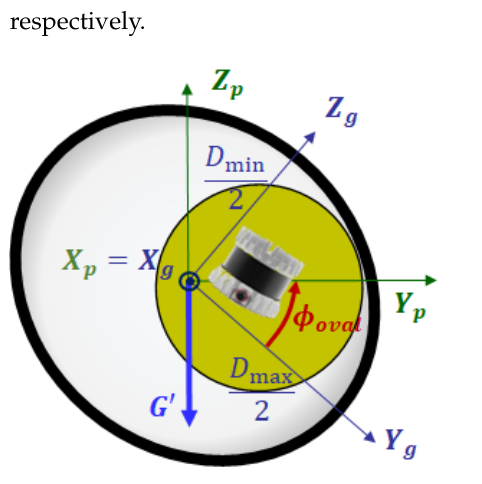
Figure 6. Cross section view of two pipe frames.